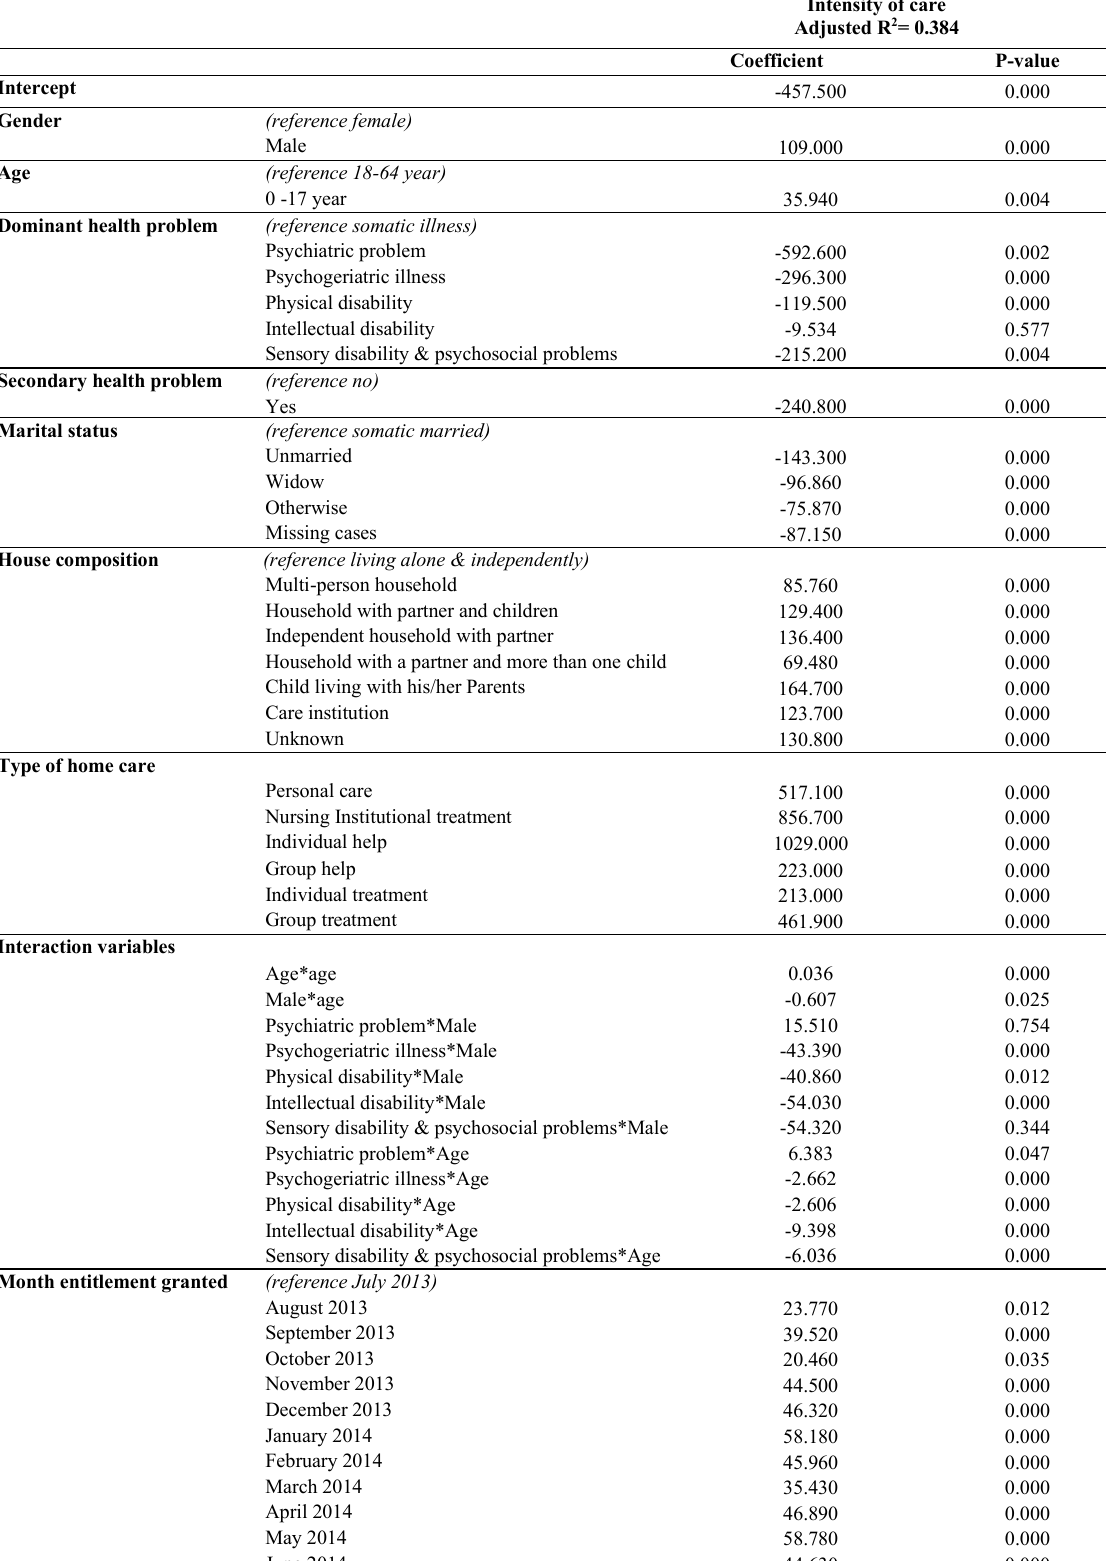
Table A1: Model 2 linear model for home care intensity younger than 65 (excerpt: excluding care office